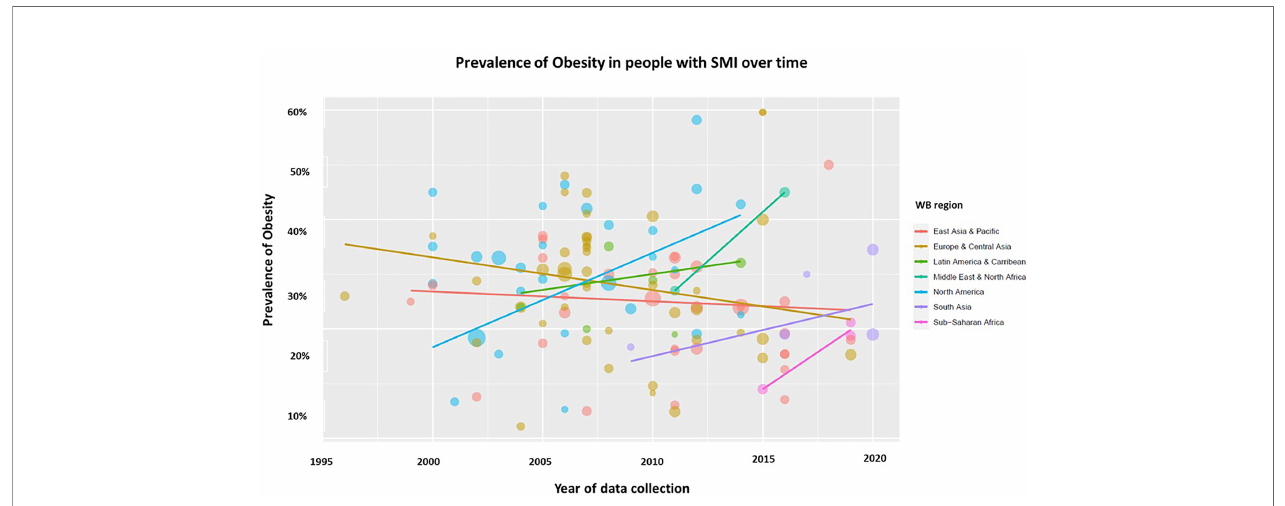
FIGURE 4 | Weighted linear regression models between the prevalence of obesity and time according to World Bank region. Data on global trends in the prevalence of obesity in people with SMI from 1995 to 2020 from the World Bank regions of the world show differences in the trend of the prevalence of obesity. The area of the dots corresponds to the sample size of each study. WB, World Bank; SMI, Severe mental illness.